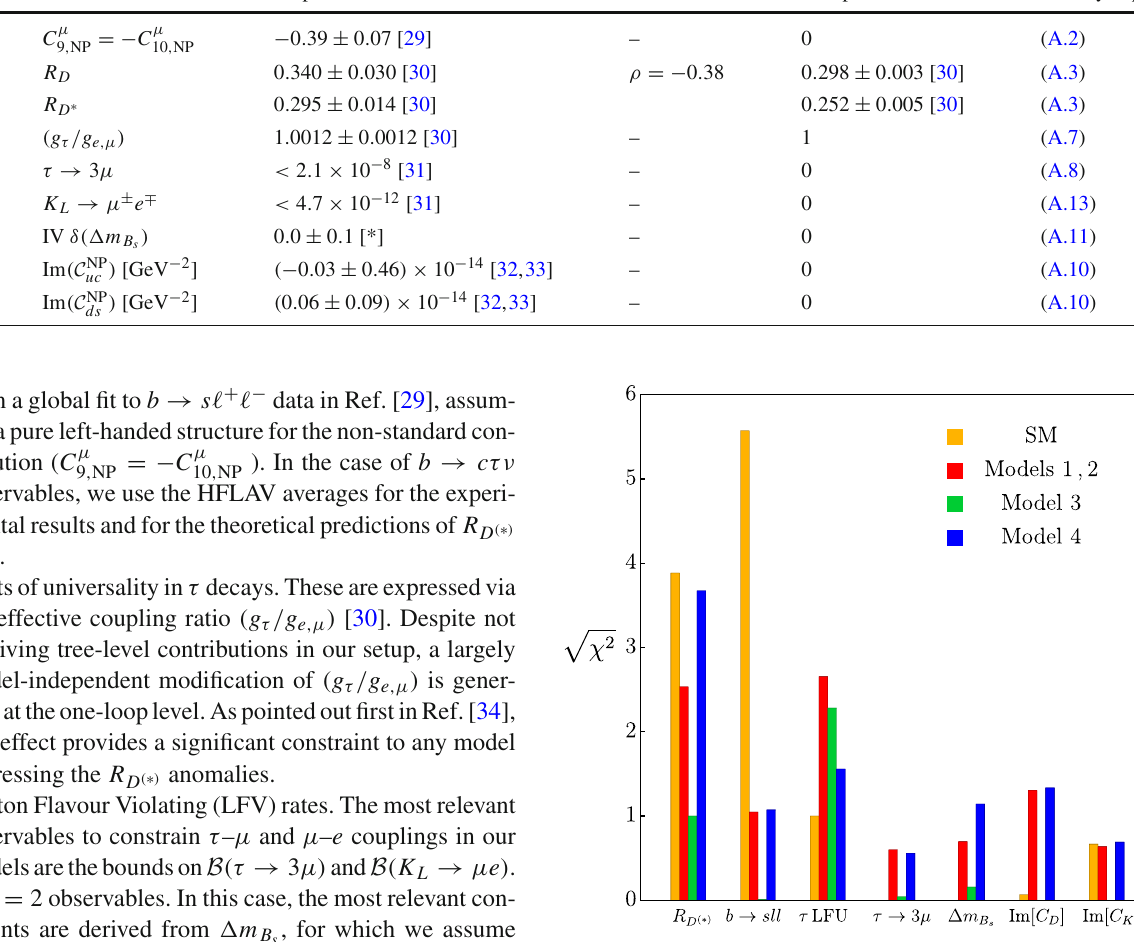
Fig. 1 Contribution to